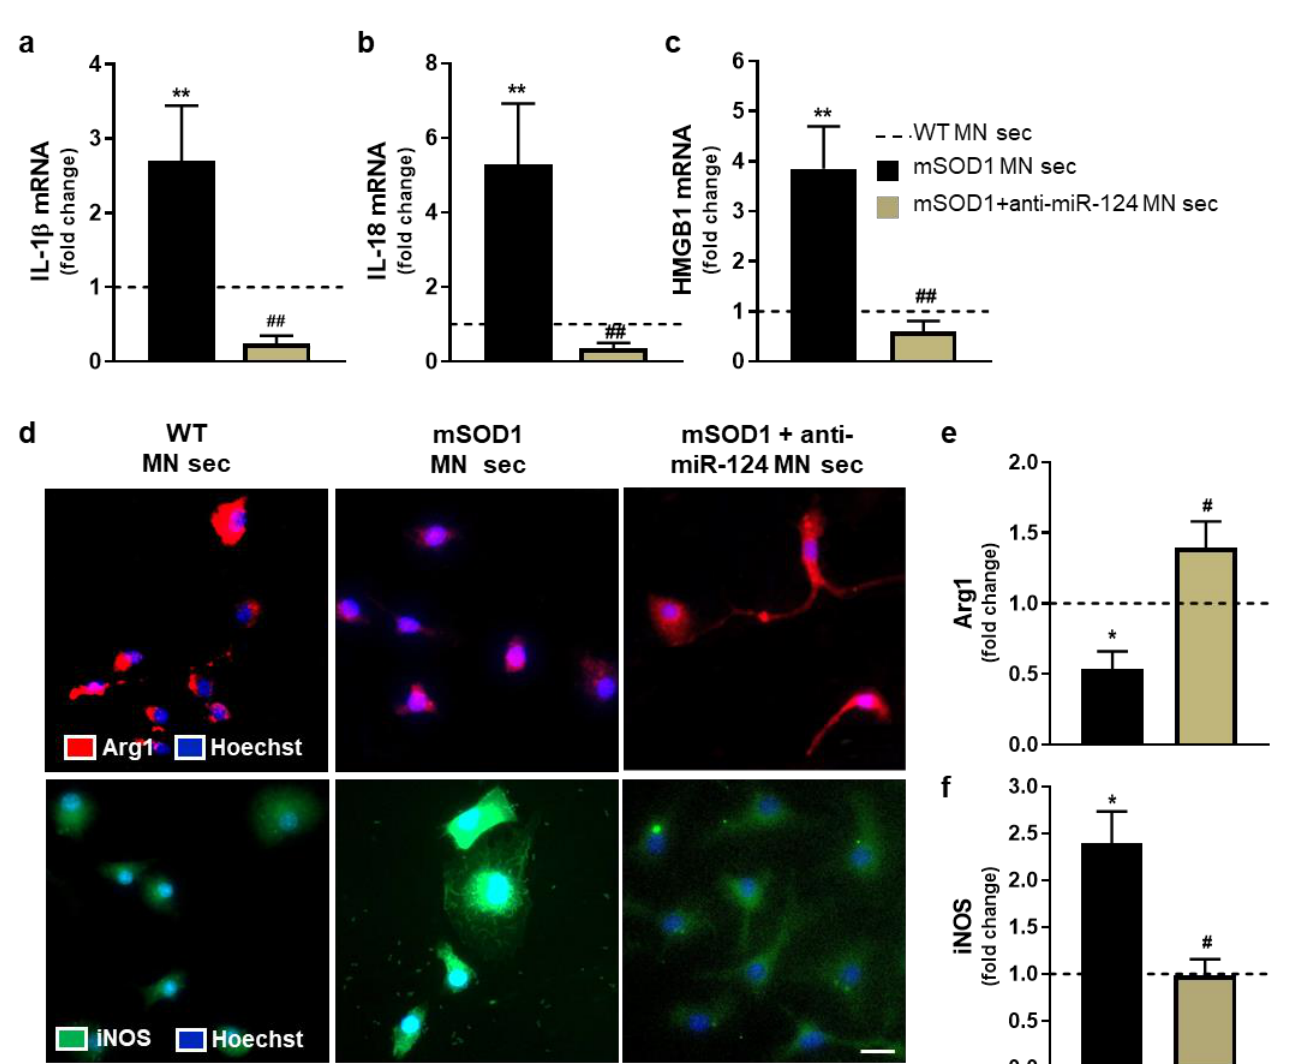
Figure 5. Secretome from mSOD1 MNs enriched in miR-124 activates the polarization of microglia from the SC of the WT mouse into a specific pro-inflammatory phenotype, while that from anti-miR-124 treated mSOD1 MNs sustain the home- ostatic microglia subtype. Two days in vitro primary SC microglia were incubated with secretomes from untreated and anti-miR-124-treated mSOD1 MNs for 4 h. mRNA levels of ( a ) IL-1β, ( b ) IL-18, and ( c ) HMGB1 were evaluated by reverse transcriptase quantitative real-time PCR (RT-qPCR). β-actin was used as the reference gene. ( e , f ) iNOS and Arg 1 protein levels (in green and red, respectively) were evaluated by immunocytochemistry using specific antibodies and ( d ) repre- sentative images are shown. ( e , f ) Quantification of total fluorescence used Image J software, which was normalized to the total number of cells. Results are mean ± SEM from at least 3 independent experiments and are expressed as fold change vs. WT microglia incubated for 4 h with the WT MN secretome (dashed line). ** p < 0.01 and * p < 0.05 vs. cells incubated with the WT MN secretome; ## p < 0.01 and # p < 0.05 vs. cells treated with mSOD1 MN secretome; one-way ANOVA followed by multiple comparisons Bonferroni post-hoc correction. Scale bar: 20 μm. SC, spinal cord; Arg1, arginase 1; HMGB1, high mobility group box protein 1; IL-1β, interleukin-1 beta; IL-18, interleukin 18; iNOS, inducible nitric oxide synthase; MN, motor neuron; mSOD1, G93A mutation in superoxide dismutase 1; sec, secretome; WT, wild type.